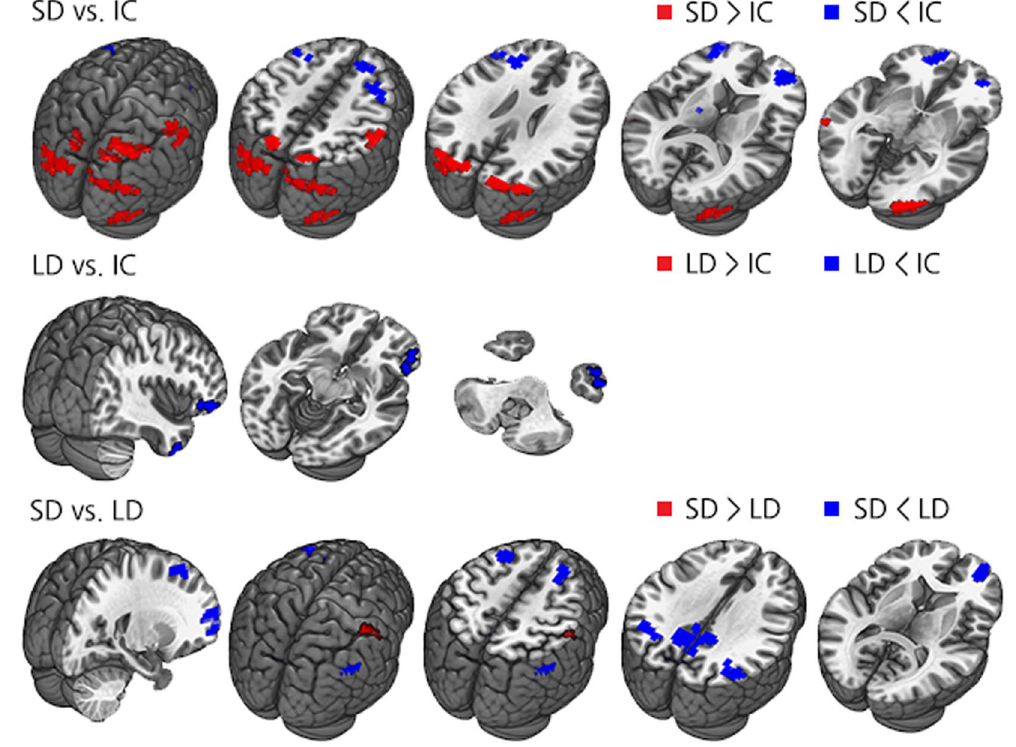
Figure 2. Group comparisons of rsFC using the bilateral SI as the seed in all group contrasts. Abbreviations: PD-MCI-SD = Parkinson’s disease with a shorter duration of parkinsonism before mild cognitive impairment diagnosis; PD-MCI-LD = Parkinson’s disease with a longer duration of parkinsonism before mild cognitive impairment diagnosis; PD-IC = Parkinson’s disease with intact cognition; rsFC = resting-state functional connectivity; SI = Substantia innominata.